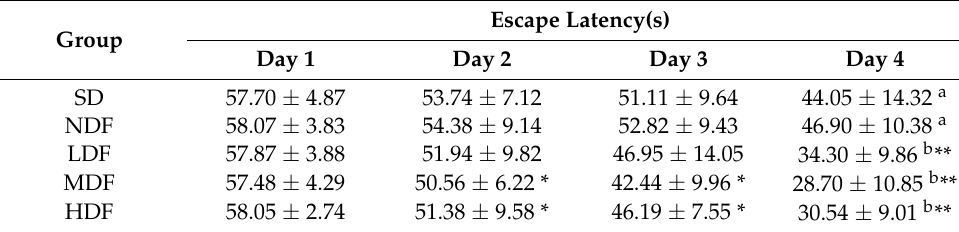
Table 4. Effect of hidden-platform acquisition training test for four consecutive days.